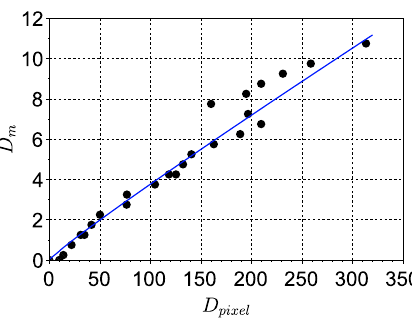
Figure 12. The pixel–metre conversion. D pixel is the flow width in pixels and D m is the flow width in metres. The rating curve was established using a measuring tape across the flow width. The data set has been fitted using Eq. (2).